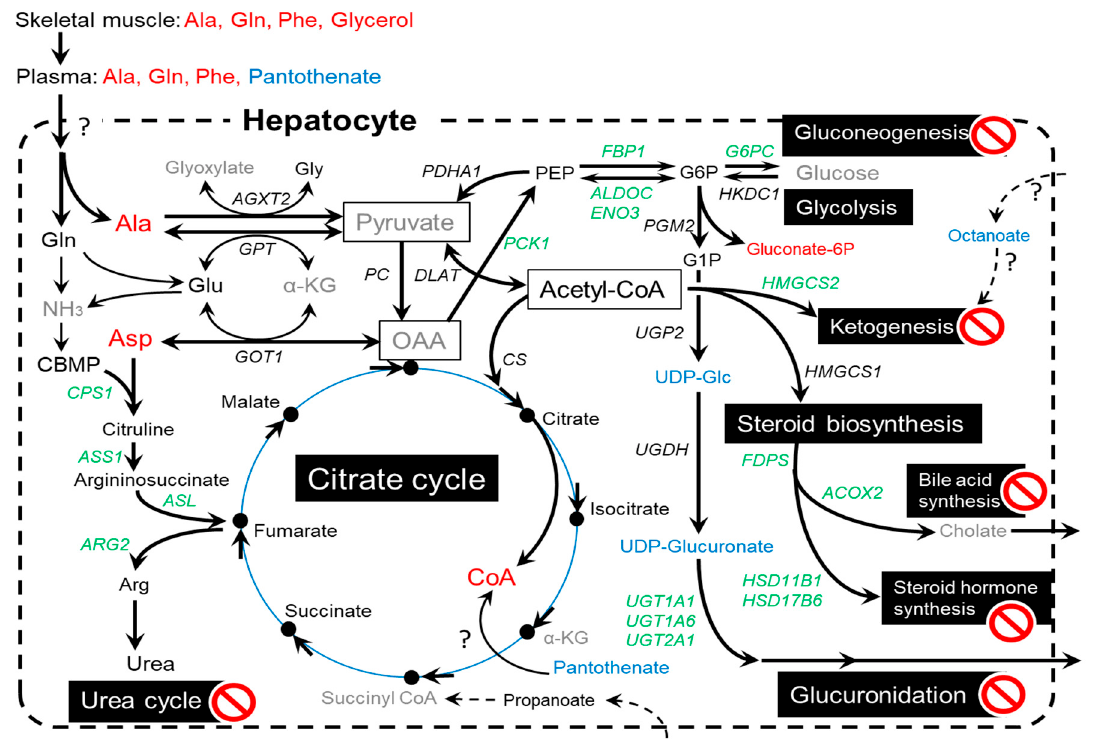
Figure 5. Hypothetic scheme of influences of maternal nutrient restriction on the fetal liver molecular pathways and metabolisms. Genes but not metabolites are italicized. Increased and decreased metabolites in the LN fetuses are indicated in red and blue, respectively. Green genes are downregulated in the LN fetuses. Grayed metabolites were not determined in this study.